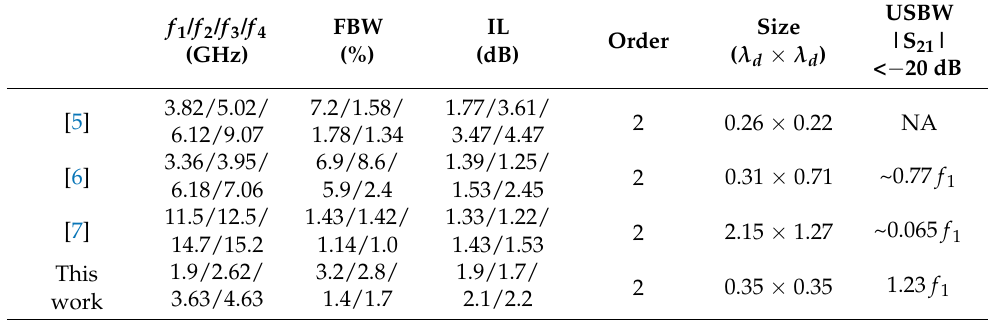
Figure 5. The measured and simulated frequency responses for the proposed QBF are shown in ( a ) narrow-range and ( b ) wide-range scopes. Table 1. Circuit performance between our design and PCB-based SIW-related QBF